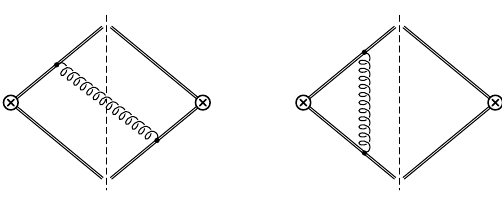
Figure 2 . Diagrams contributing to the one-loop soft